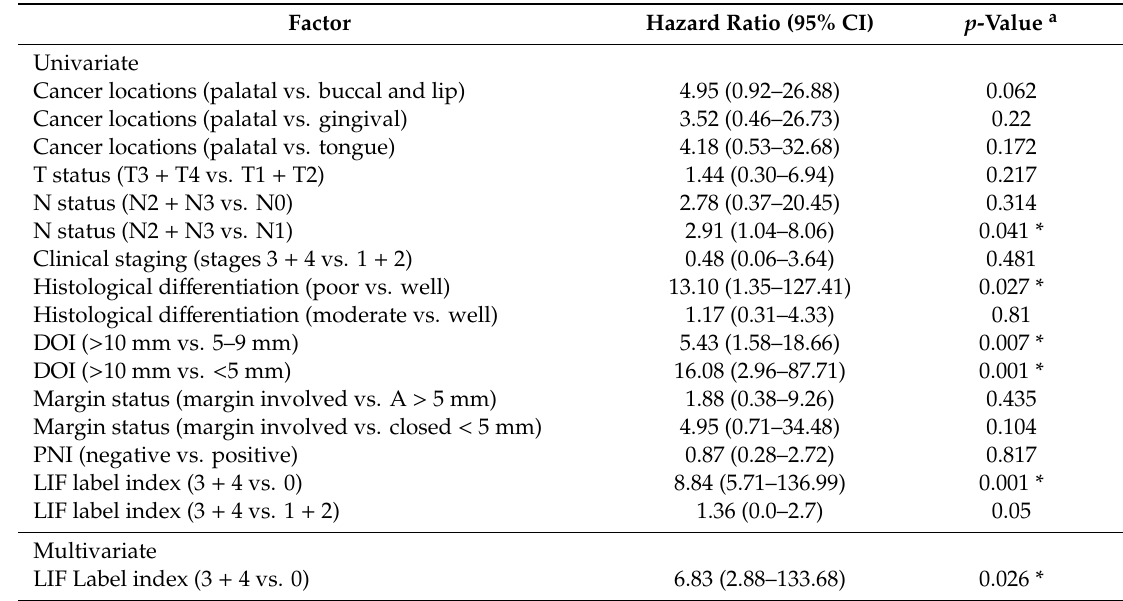
Table 2. Univariate and multivariate survival analyses of LIF and clinicopathological parameters in patients with oral squamous cell carcinoma (OSCC).